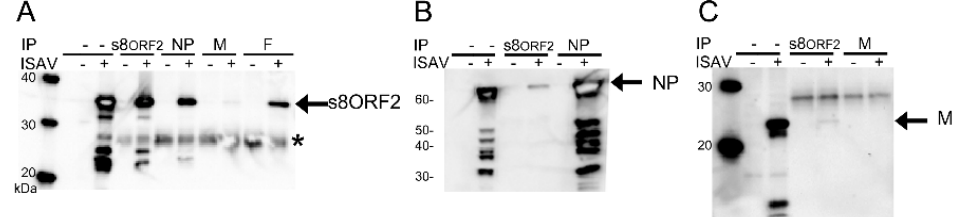
Viruses 2016 , 8 , x 8 of 19 Figure 4. Live images of EPC cells transfected with constructs expressing EGFP or s8ORF2-EGFP captured with time-laps microscopy after permeabilization of cell membranes with digitonin. Cells were treated with a hypotonic buffer added 160 µM digitonin and images were captured at fixed intervals at 40× magnification in an inverted fluorescence microscope. T0 = time zero. 3.1.3. The s8ORF2 Protein Interacts with the ISAV Nucleo-, Matrix and Fusion Proteins Immunoprecipitation indicated that the s8ORF2 protein interacts with other ISAV proteins; the nucleoprotein (NP), matrix protein (M) and fusion protein (F) in cell lysates from infected cells (Figure 5A–C). Anti-s8ORF2 antiserum used in western blotting detected the 35 kDa band representing the s8ORF2 protein after pull-down with anti-NP mAB, anti-M- or anti-F antiserum (Figure 5A). When the opposite was assayed, i.e. , pull-down with anti-s8ORF2 and WB with anti-NP- or anti-M antiserum, bands corresponding to the expected sizes of NP (68 kDa) and M (22 kDa) was observed (Figure 5B,C). For the F protein, however, an unspecific protein band with approximately the same MW as the F protein co-precipitated with anti-s8ORF2 making these results difficult to interpret (S3). The staining of M after using anti-M in immunoprecipitation was very weak indicating that this antibody has low affinity to the native protein (Figure 5C). Also, a comparatively low amount of M was pulled down using the anti-s8ORF2 in immunoprecipitation (Figure 5C). A heavily stained band below 20 kDa from a non-IP sample was also observed in the M-blot (Figure 5C), possibly indicating